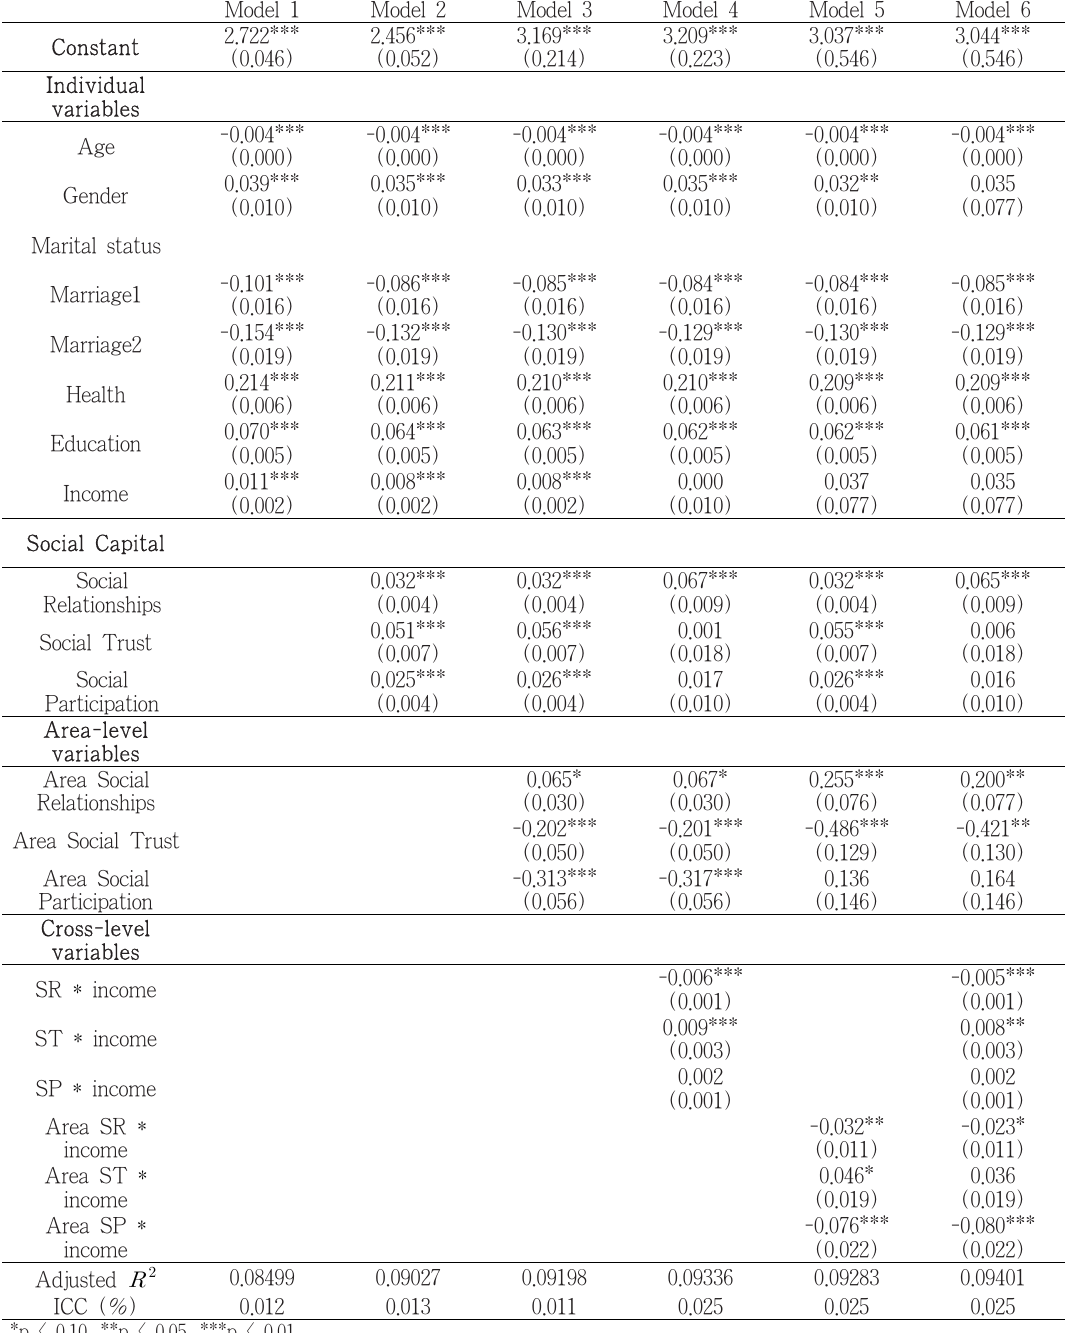
<Table 5> Alternative results of PEM with a positive